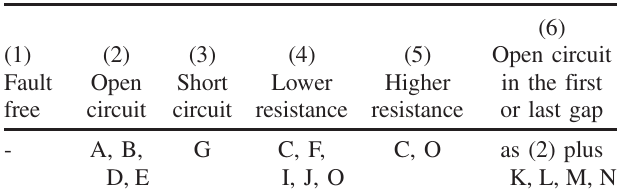
TABLE IV. Troubleshooting chart for identification of faults in high-voltage grading system of electrostatic accelerators.